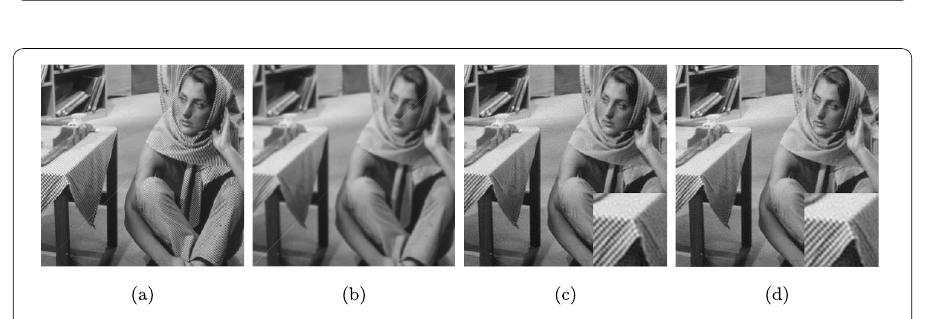
Figure 2 Deblurring performance comparison on the Babara image. ( a ) Original image, ( b ) noisy and blurred image (PNSR = 23.31), ( c ) the deblurred image using classical ADMM with soft shrinkage (PSNR =